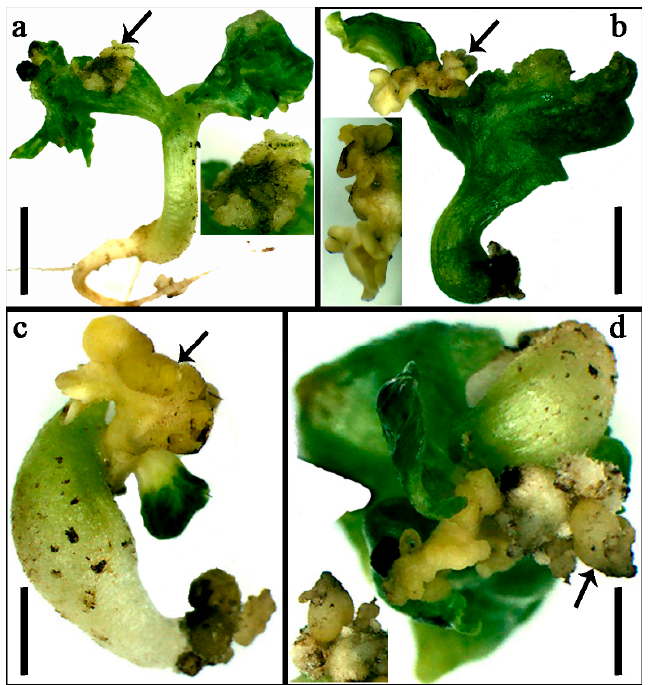
Figure 6. Phenotypes of transgenic cotton seedlings ectopically expressing GhDNF-YB22 : ( a ) seedlings produced a callus-like structure; ( b ) seedling produced embryo-like organs; ( c ) embryo-like organs were substituted for leaf growth; and ( d ) embryo-like structures developed from the callus. Bars: 0.5 mm ( a , b ); and 0.1 mm ( c , d